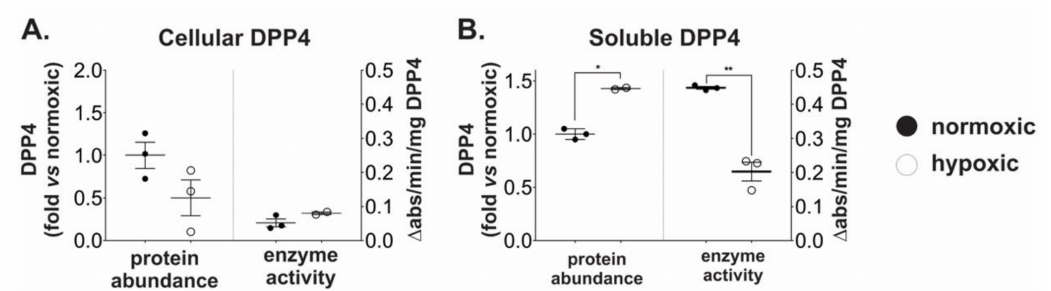
Figure 2. Hypoxia induces shedding of inactive DPP4 from ovarian cancer cells. OVCAR4 cells were cultured under normoxia or hypoxia for 48 h. ELISA for quantitation of DPP4 protein abundance and enzyme assays for DPP4 activity were performed on ( A ) cell lysates and ( B ) conditioned media. Enzyme activity is expressed as specific activity relative to the measured abundance of DPP4. The